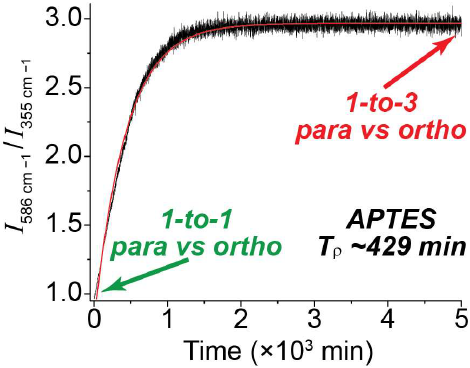
8 of 13 Figure 4. Example Raman spectra of the J : 0 → 2 ‘para’ spin peak (355 cm −1 ) and J : 1 → 3 ‘ortho’ spin peak (586 cm −1 ), taken both ( a ) immediately after loading the pH 2 -enriched gas into the valved NMR tube and ( b ) after 65 h had elapsed. The relative abundances of the two spin isomers can be deter- mined from their relative peaks (e.g., the pH 2 fraction is nearly 50% at t = 0 and reverts to the thermal equilibrium value of 25% within 65 h). See Supplemental Figure S2 for a version of this plot with the peaks overlaid, demonstrating consistent shift and linewidth between time points. In order to determine the para-to-ortho reconversion rate, the ratios of the 586 cm −1 vs. 355 cm −1 peak integrals were plotted over an extended timeline (Figure 5). At the start time, the ratio of the peaks was approximately 1-to-1, indicating a pH 2 enrichment of ~50%. Over time, as pH 2 converted to oH 2 , the ratio grew to approximately [40] 3-to-1; this